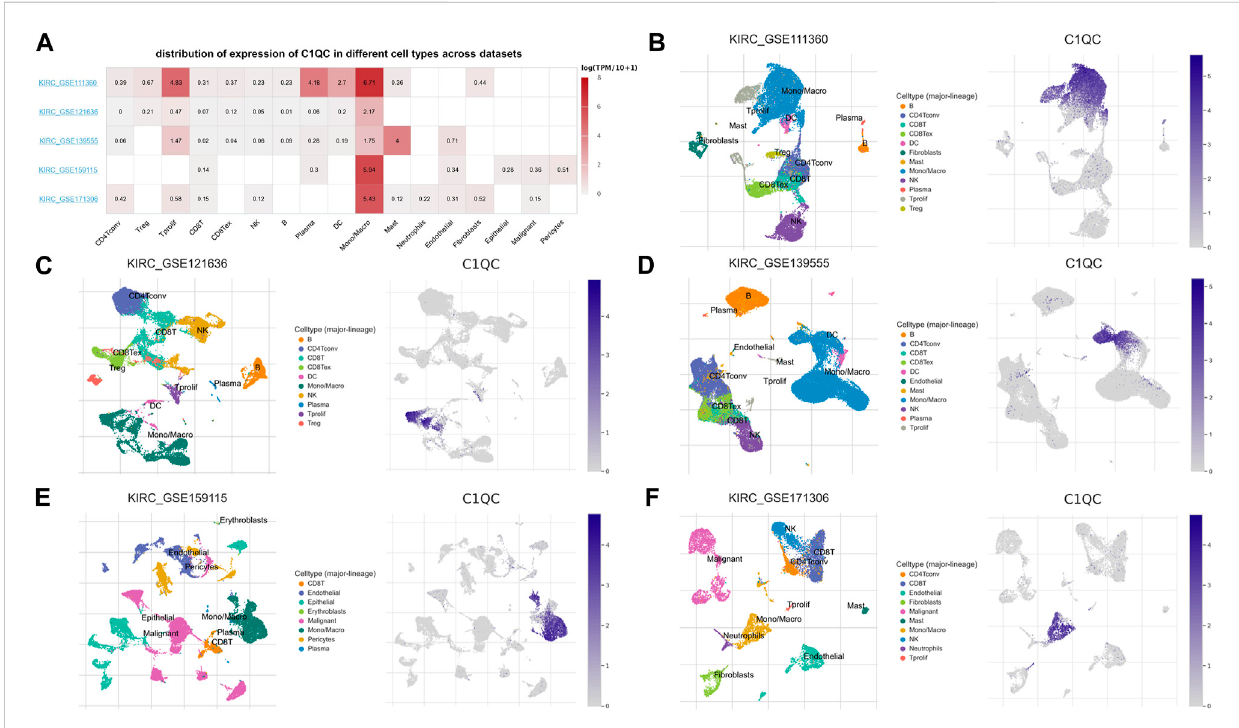
FIGURE 5 C1QCatsingle-celllevel. (A) HeatmapdemonstratesC1QCexpressionincellsfromavarietyofdatabases. (B – F) C1QCsingle-cellclusterindifferent